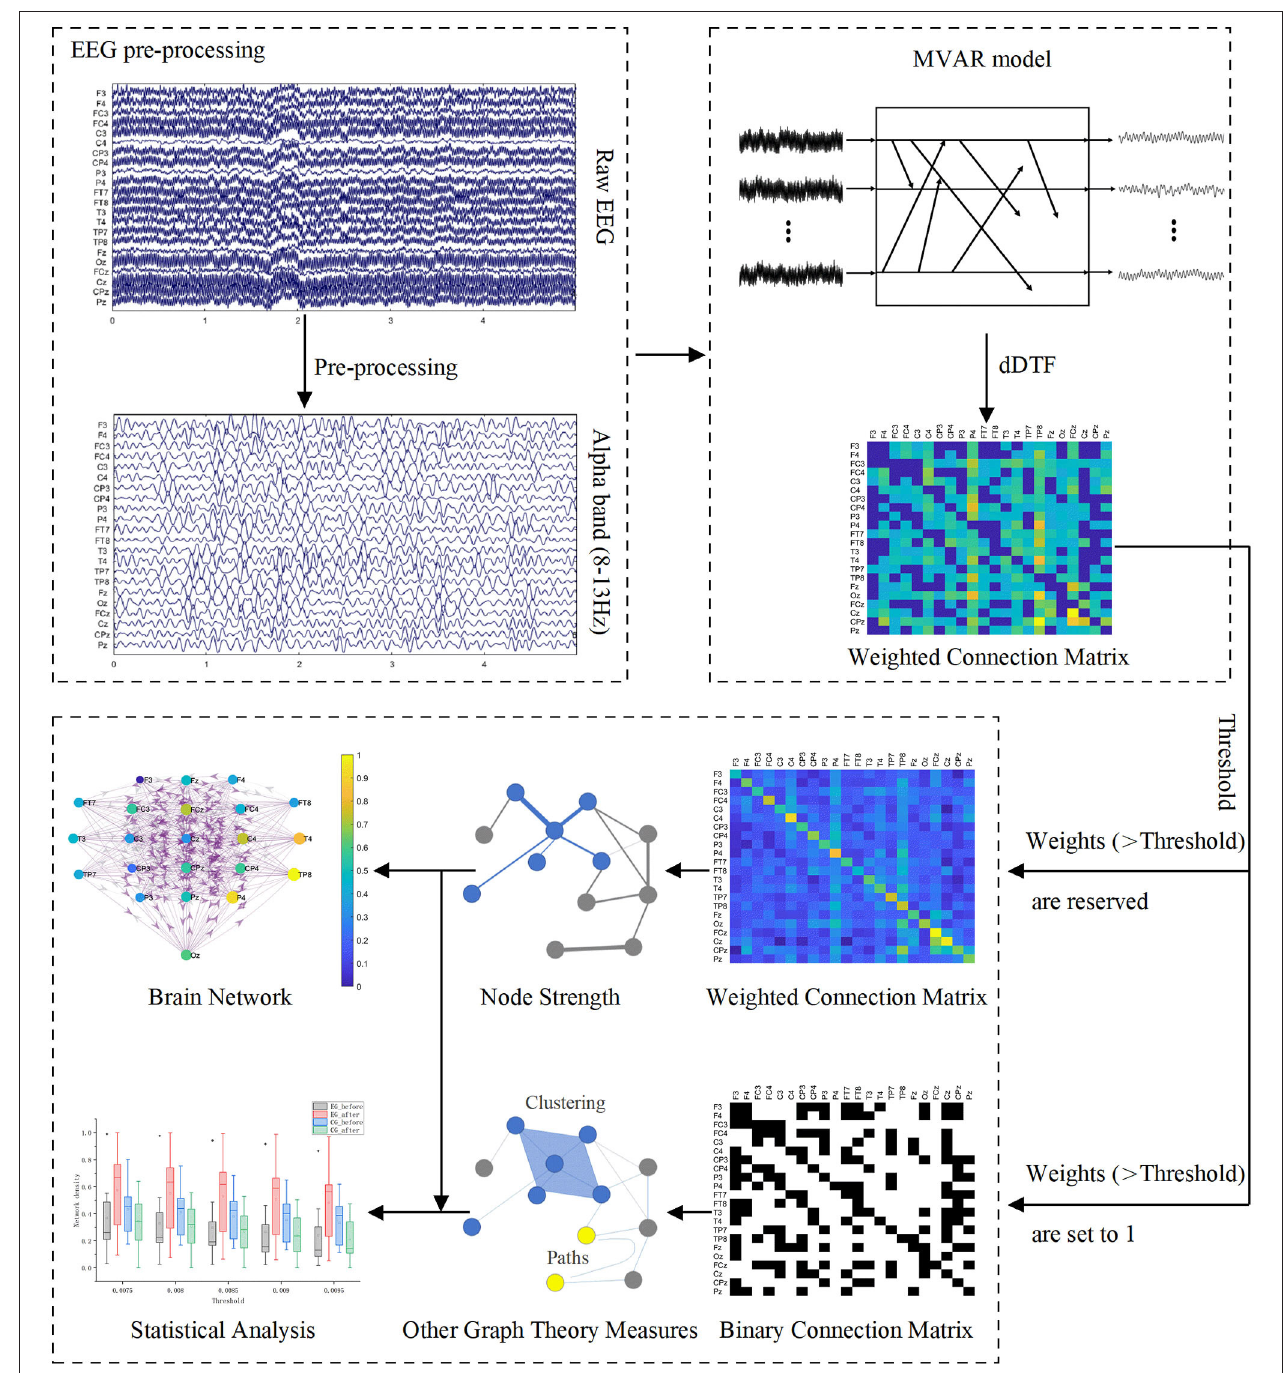
FIGURE 3 | Schematic diagram of building functional brain networks based on EEG data using graph